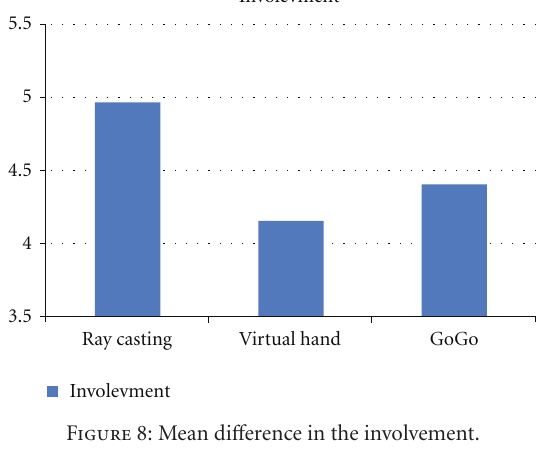
Figure 10: Mean di ff erence in the collaborative e ff ort.